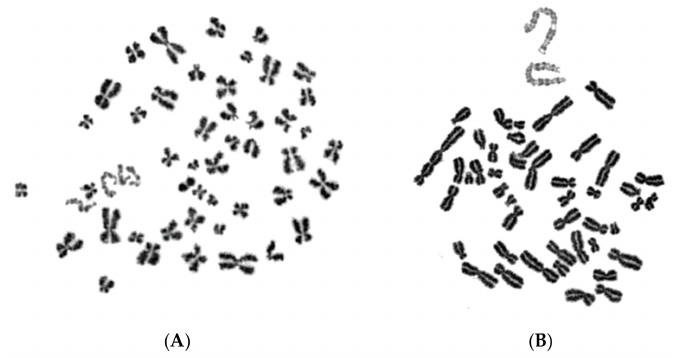
Figure 2. G1 and G2 MN PCCs. When main nuclei in heterophasic micronucleated cells generated by exposure of G 0 -lymphocytes to IR (4 Gy) enter mitosis, chromosome shattering is not observed in the MN PCCs if the morphology of chromosomes entrapped in MN is classified as G1 ( A ) or G2 phase ( B ). Anaphase lagging chromosomes entrapped in MN can undergo chromatid disjunction ( A ), and complete DNA replication without impairment in their duplication ( B ). The di ff erent level of chromatin condensation between MN chromosomes and those of the main nuclei leads to dissimilar shades of staining, making them easily distinguishable. Darkly stained metaphasic chromosomes belong to main nuclei, while lightly stained chromosomes were entrapped in